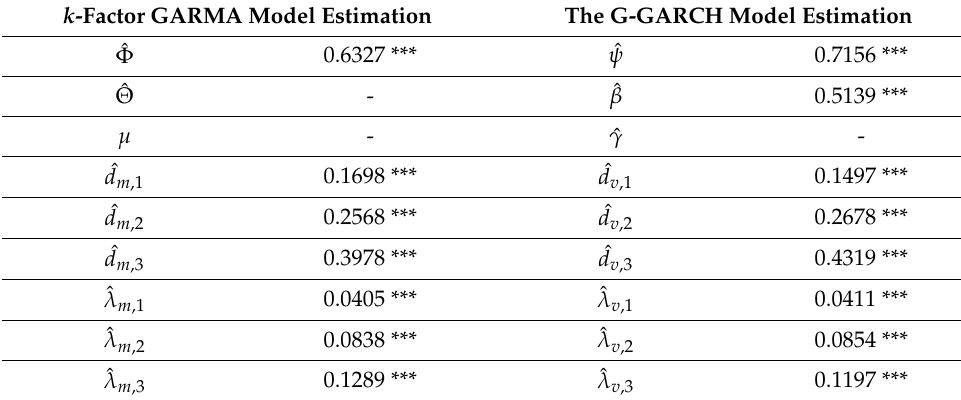
Table 5. The k -factor GARMA-G-GARCH estimation